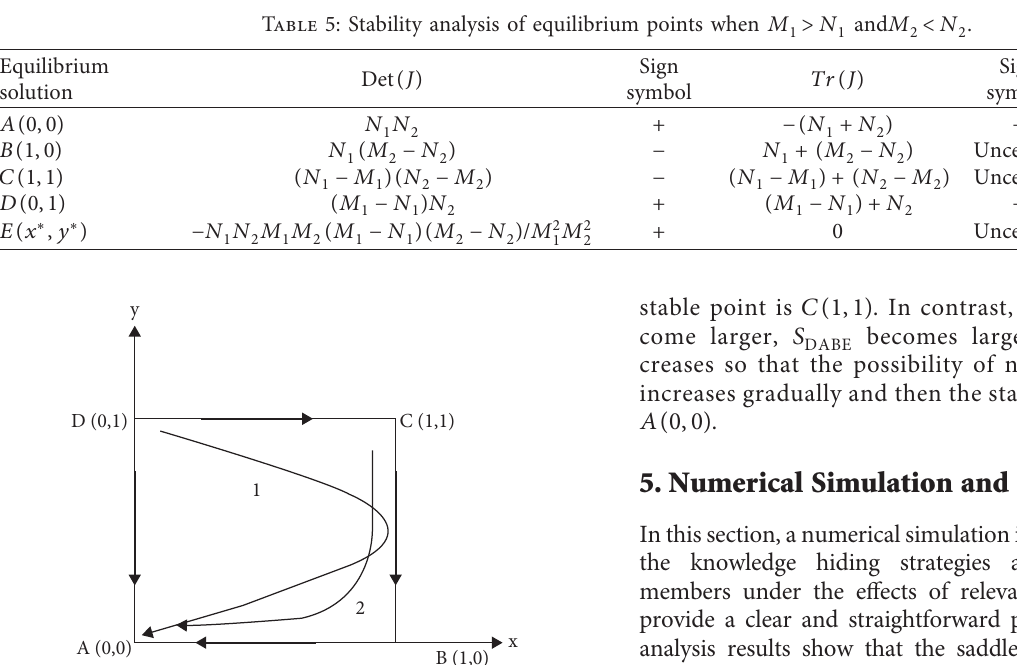
Figure 3: The stable strategy of the evolutionary game system when M > N and M < N 1 1 2 2